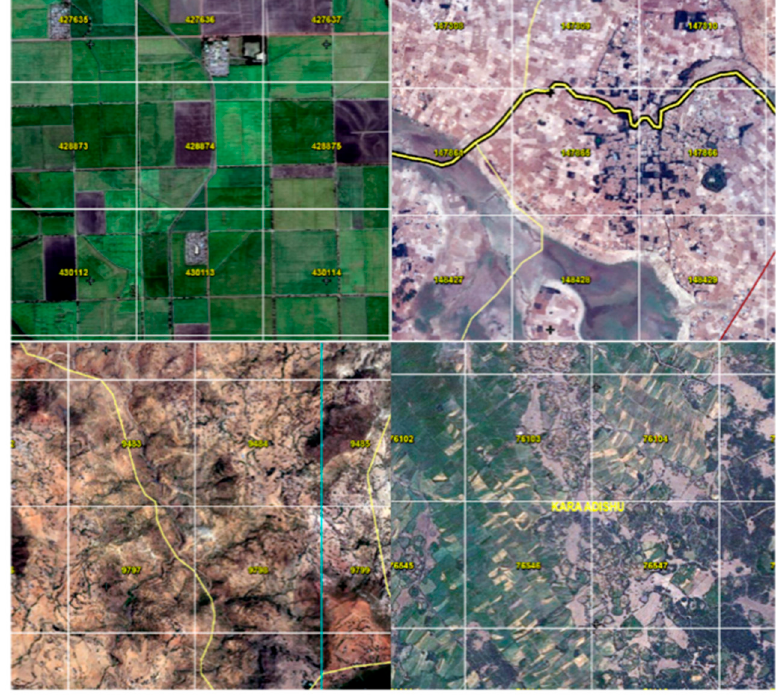
Figure 2. Examples of different cropland areas in Ethiopia illustrating the diversity in field size, shape, and delineation. Based on very high-resolution imagery (0.5 m / pixel) overlaid with 1 km × 1 km grids. Map data © 2016 Google.